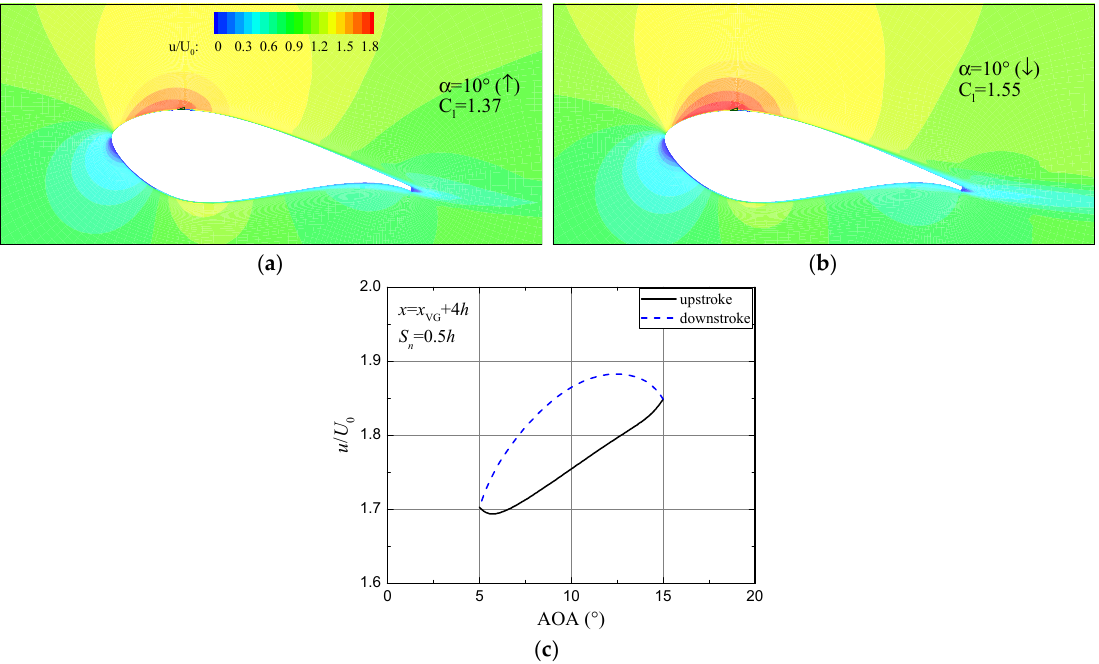
Figure 13. Contour of streamwise velocity field around the airfoil and the streamwise velocity variation in the boundary layer at x = x VG + 4 h and S n = 0.5 h . ( a ) α mean = 10 ° during upstroke; ( b ) α mean = 10 ° during downstroke; ( c ) streamwise velocity variation.